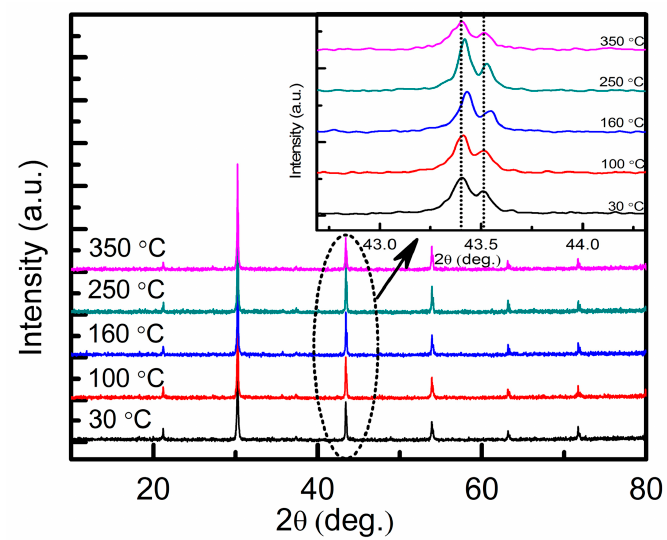
Figure 9. Temperature dependence of powder X-ray diffraction patterns of the crashed PLN-0.07PT crystal. The insert shows the (200) reflections.